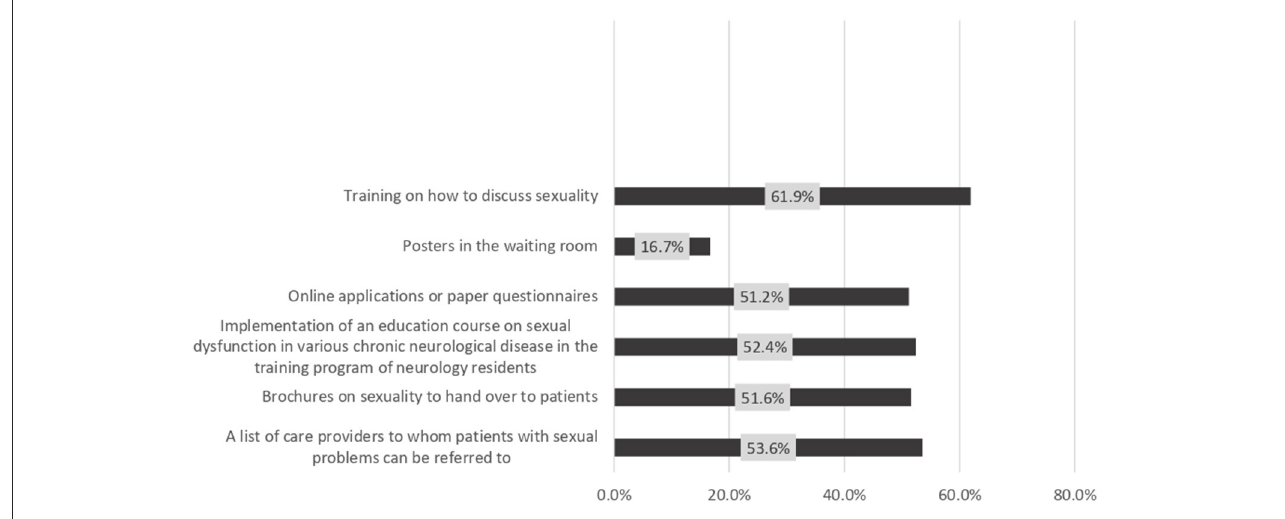
FIGURE4 Facilities that might enhance the discussion on sexuality.